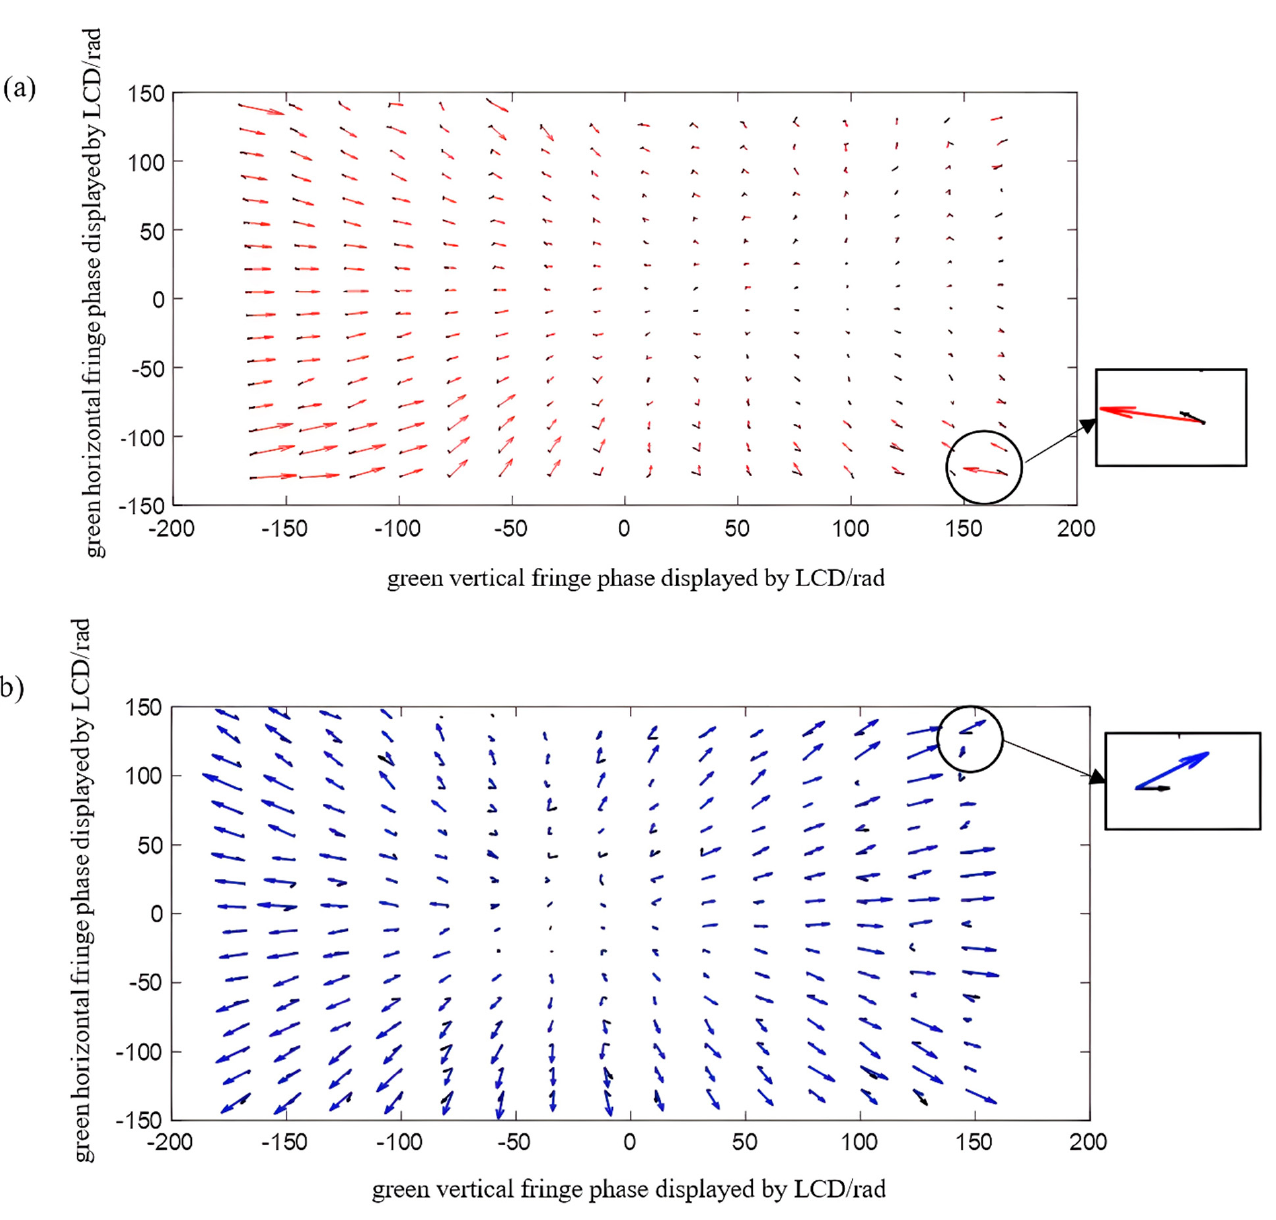
Figure 15. Projection radial chromatic aberration vector change diagram before and after pre-compensation: ( a ) vector change diagram of the red and green channels; ( b ) vector change diagram of the blue and green channels.